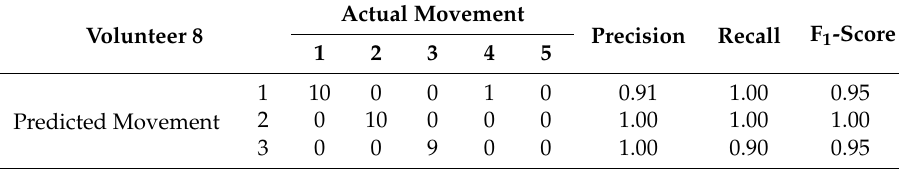
Table A8. Results Volunteer 8.